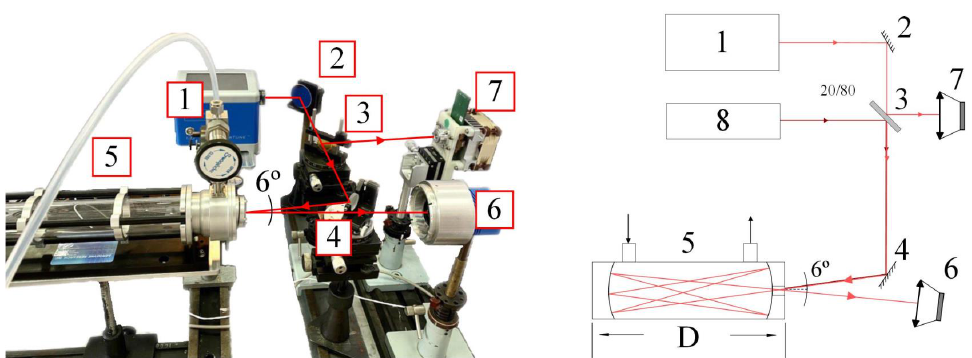
Figure 3. Optical scheme of the experimental